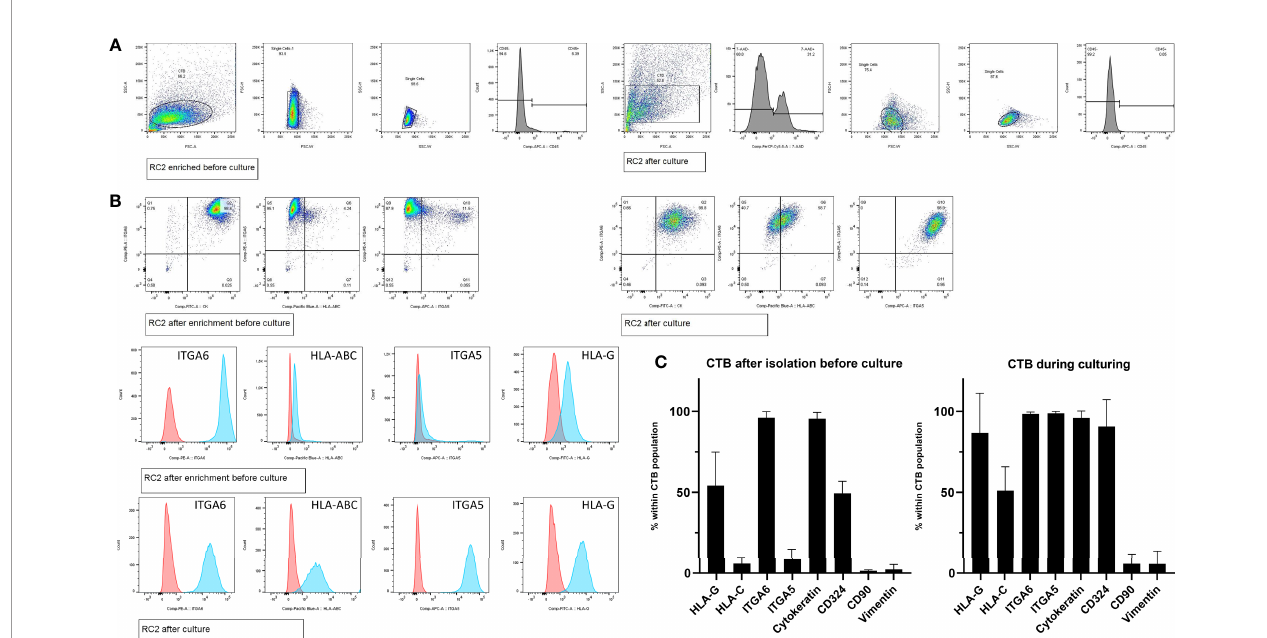
FIGURE 2 | Cell frequencies by fl ow cytometry after enrichment and during CTB culturing. (A) Representative gating strategy from one donor (RC2), to select singlet cells by forward-sideward scatter that were viable (7-AAD neg ) and non-hematopoietic (CD45 neg ). (B) Representative fl ow cytometry dot blots and histogram plots of trophoblasts from one donor (RC2), after cell enrichment but before culturing (upper panel) and during culturing in CTB stem cell medium (lower panel). (C) Mean cell frequencies from seven donors showing the positivity for each of the markers of interest, both after cell enrichment but before culturing (left graph) and during culturing in CTB stem cell medium (right graph).